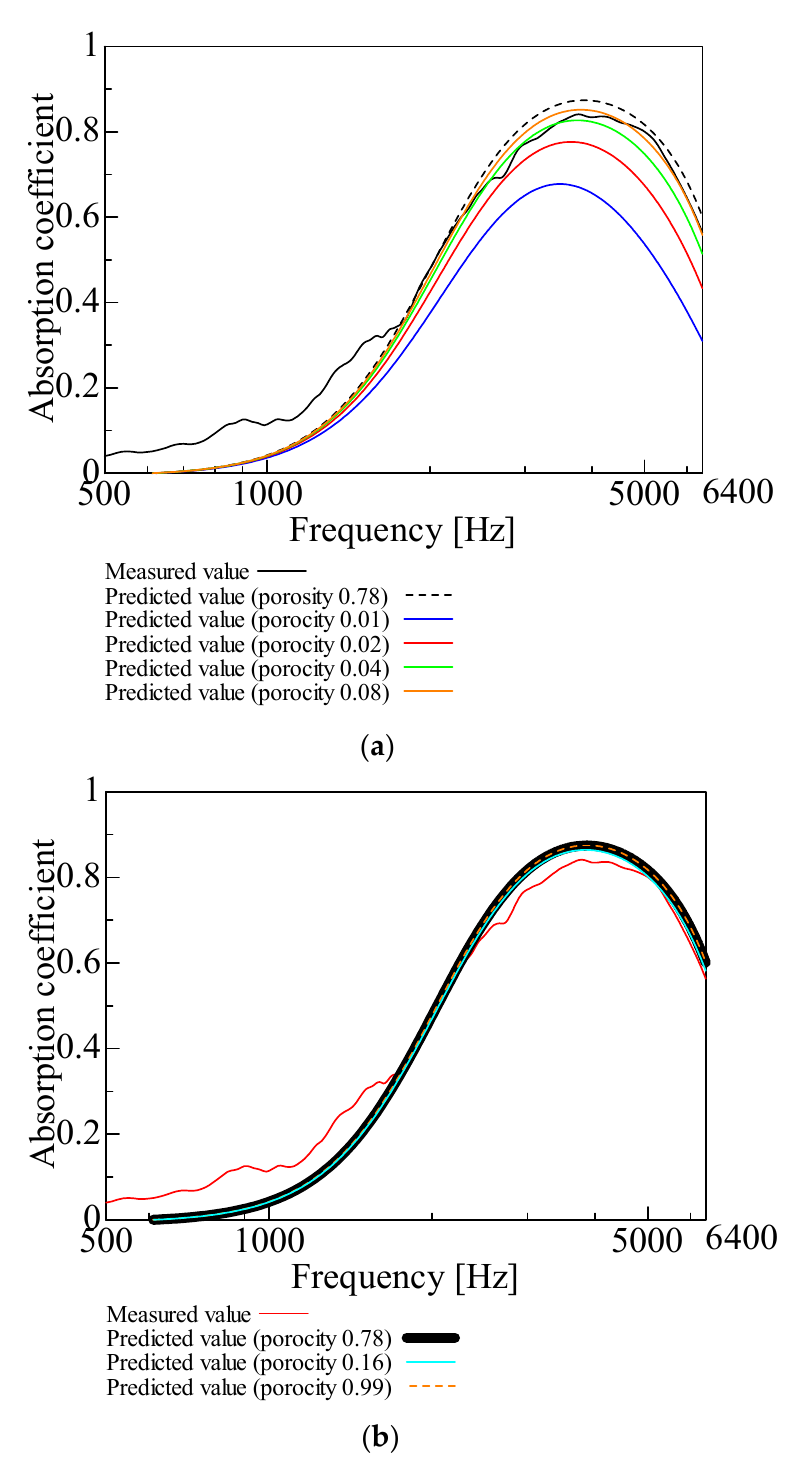
Figure 4. Variation of predicted value due to variation of porosity: ( a ) porosity: 0.01, 0.02, 0.04, 0.08, and 0.78; ( b ) porosity: 0.16, 0.99, and 0.78.